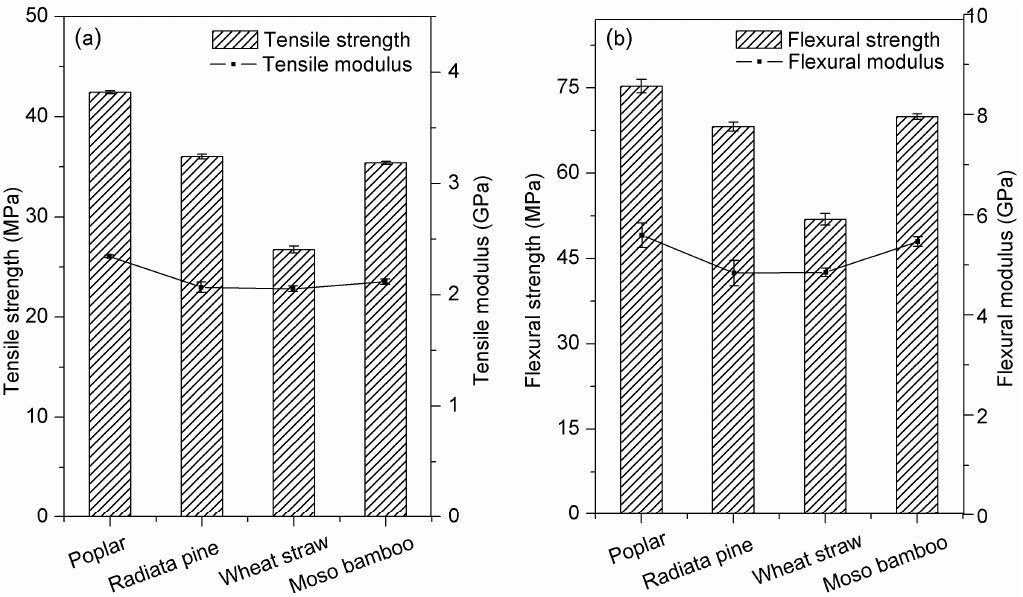
Figure 4. The value of the mechanical properties of composites with different species: ( a ) tensile; ( b ) flexural.